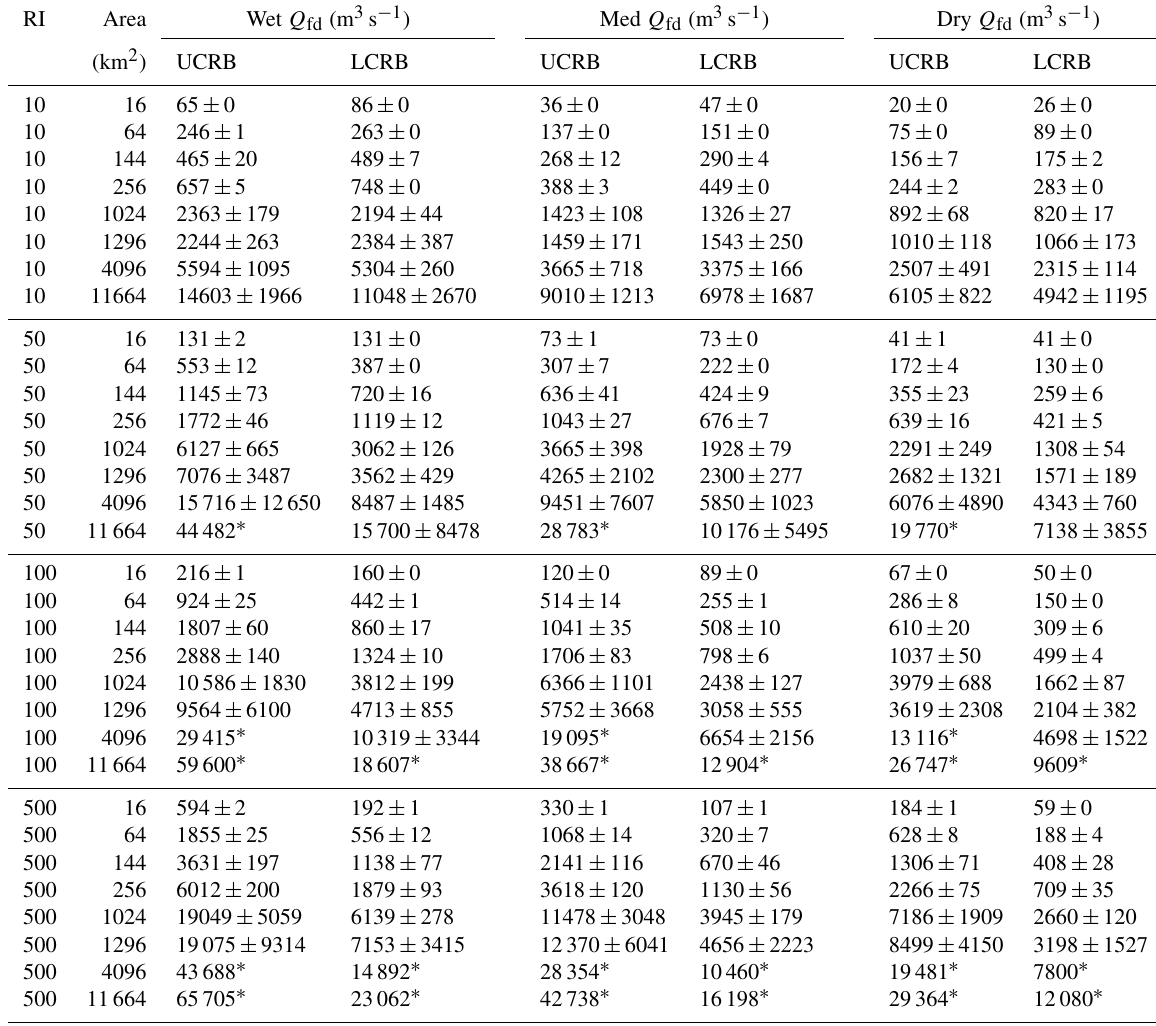
Table 2. Maximum Q fd for the Upper Colorado River Basin (UCRB) and Lower Colorado River Basin (LCRB). Note that data are all sampled from time intervals of measurement ≤